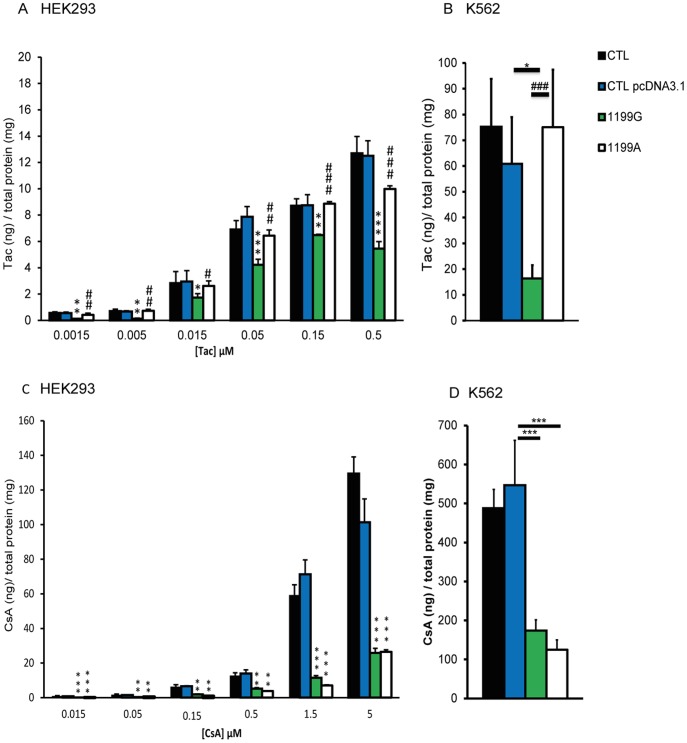
The ABCB1 1199A variant differentially affects Tac and CsA efflux.Intracellular accumulation of tacrolimus after 120 min of incubation (N  =  3) (A) at six different concentrations (0.0015–0.5 μM) in CTL HEK293, CTL HEKpcDNA3.1, HEK1199G and HEK1199A and (B) at 0.05 μM in CTL K562, CTL K562 pcDNA3.1, K5621199G and K5621199A. Intracellular accumulation of CsA after 120 min of incubation (N  =  3) (C) at six different concentrations (0.015–5 μM) in CTL HEK, CTL HEKpcDNA3.1, HEK1199G and HEK1199A and (D) at 0.5 μM in CTL K562, CTL K562pcDNA3.1, K5621199G and K5621199A. The intracellular accumulation of Tac or CsA in each cell line was normalized by reporting the absolute amounts of Tac or CsA (in ng) on the total amount of proteins in cell extracts, expressed in mg. * compared to CTL pcDNA3.1 *p<0.05 **p<0.01 ***p<0.001, # compared to 1199G/WT #p<0.05 ##p<0.01 ###p<0.001.